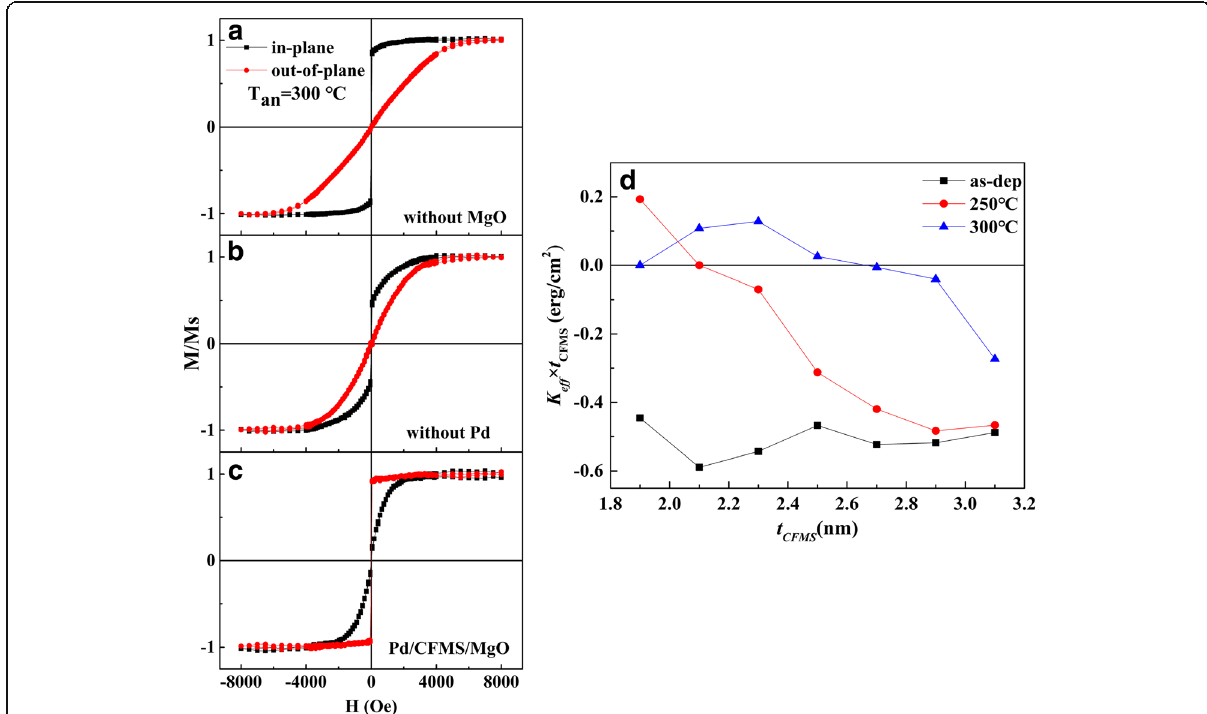
Fig. 3 The M-H loops of a Ta/Pd/CFMS/Pd, b Ta/CFMS/MgO/Pd, and c Ta/Pd/CFMS (2.3 nm)/MgO (1.3 nm)/Pd annealed at 300 °C and d the CFMS layer thickness dependence of K eff × t CFMS product for Ta/Pd/CFMS ( t CFMS )/MgO (1.3 nm)/Pd annealed at different